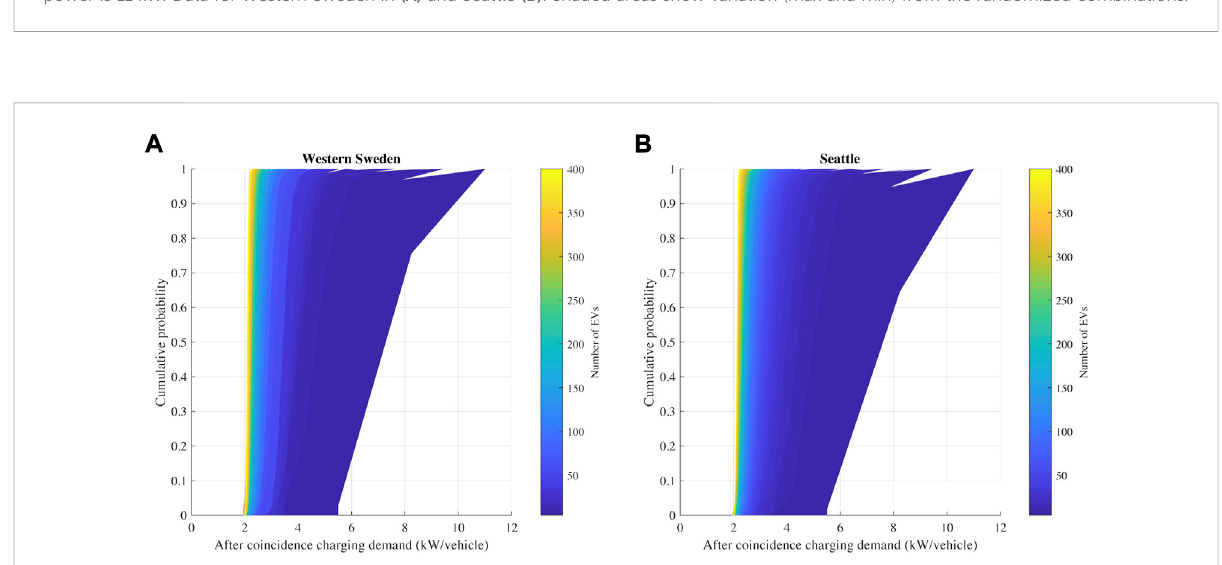
FIGURE 5 Empirical Cumulative Distribution Function (CDF) of after-coincidence charging power demand based on 132,000 randomized combinations of vehicles. Results for Western Sweden (A) and Seattle (B) . The nominal charging power is 11 kW, the electricity demand per km is assumed to be 0.2 kWh/km and charging location is home